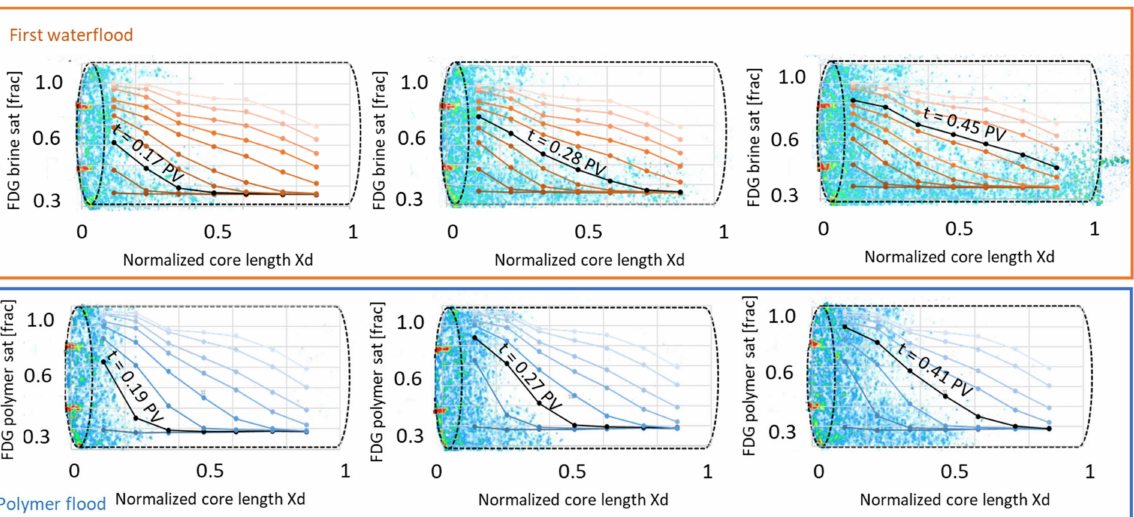
Figure 13. Comparison of sequential water and polymer injection in the same oil-wet limestone core